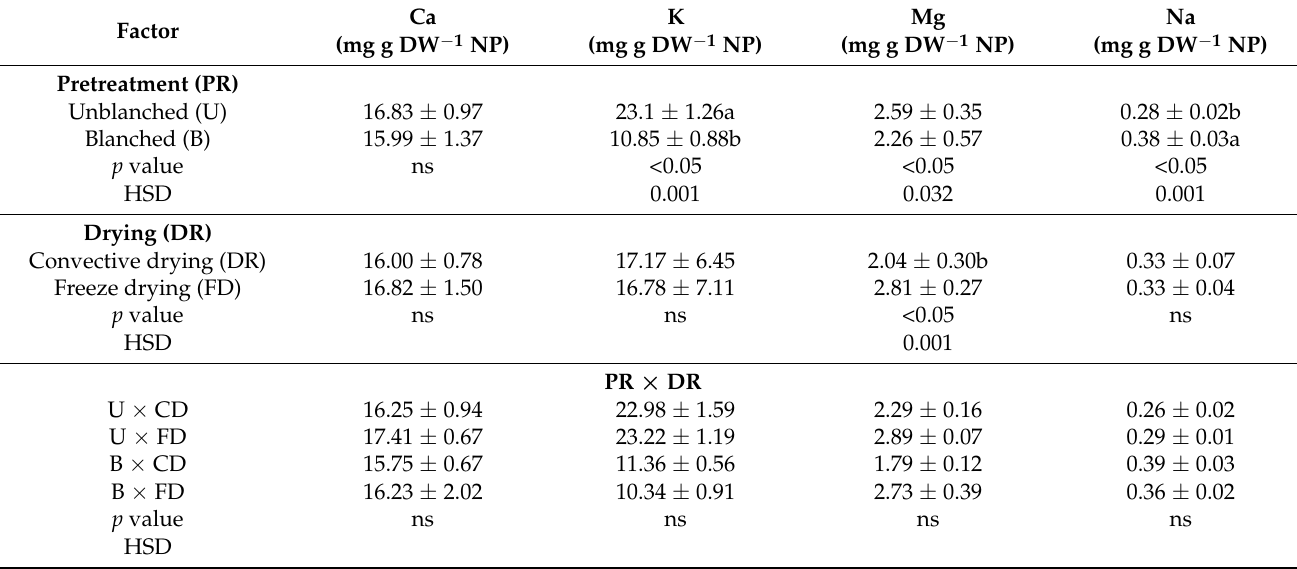
Table 5. The interaction effect of pretreatment (PR) and drying (DR) factors on mineral content of nettle powders obtained by different processing methods. Data are mean ± standard deviation of the mean. Mean values belonging to the same factor without common letters are statistically different according to HSD ( p ≤